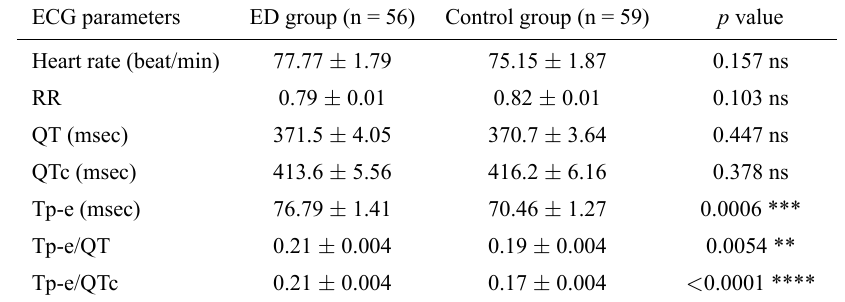
Table 2. Comparison of ECG parameters in erectile dysfunction (ED) patient and healthy control groups.